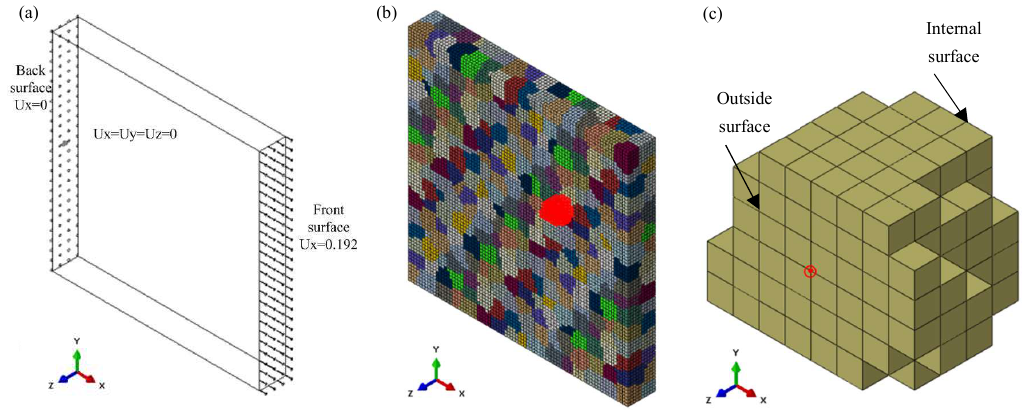
Figure 3. Effect of grain number ( a ) and unit number ( b ) on the representative volume element (RVE) model.